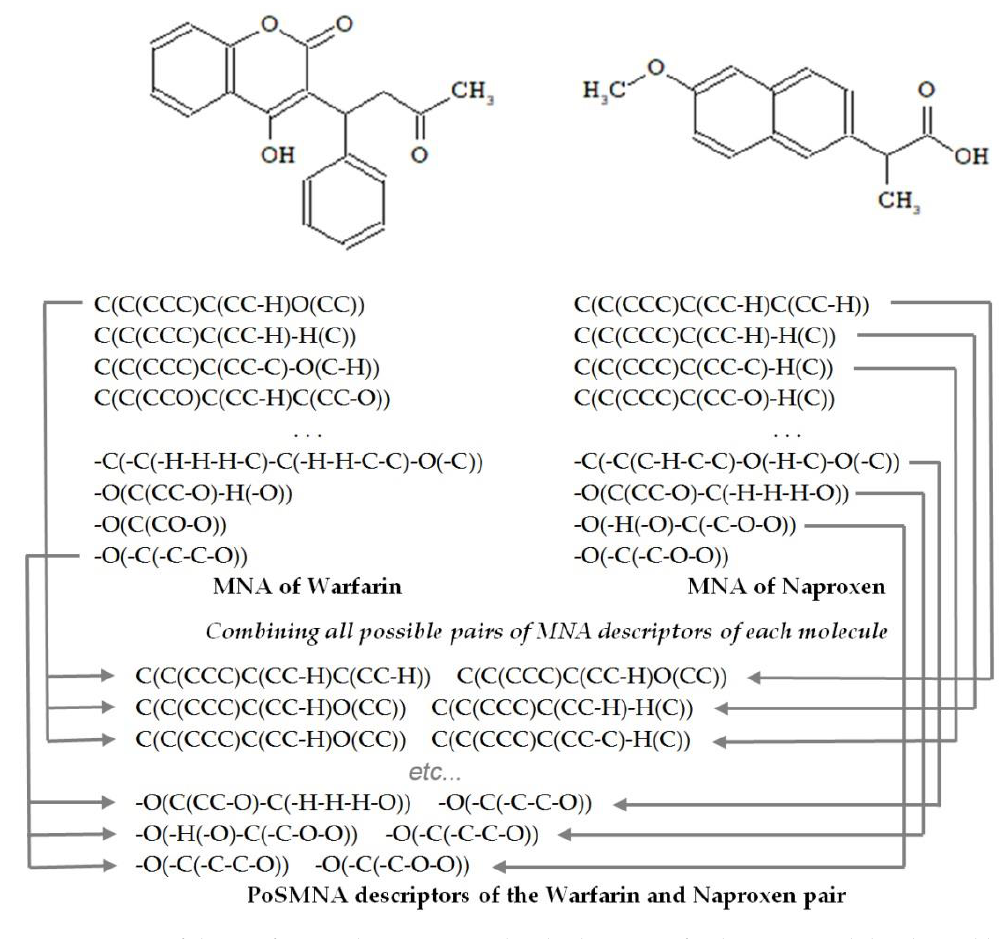
Figure 1. Representation of the warfarin and naproxen molecules by Pairs of Substances Multilevel Neighborhoods of Atoms (PoSMNA) descriptors.